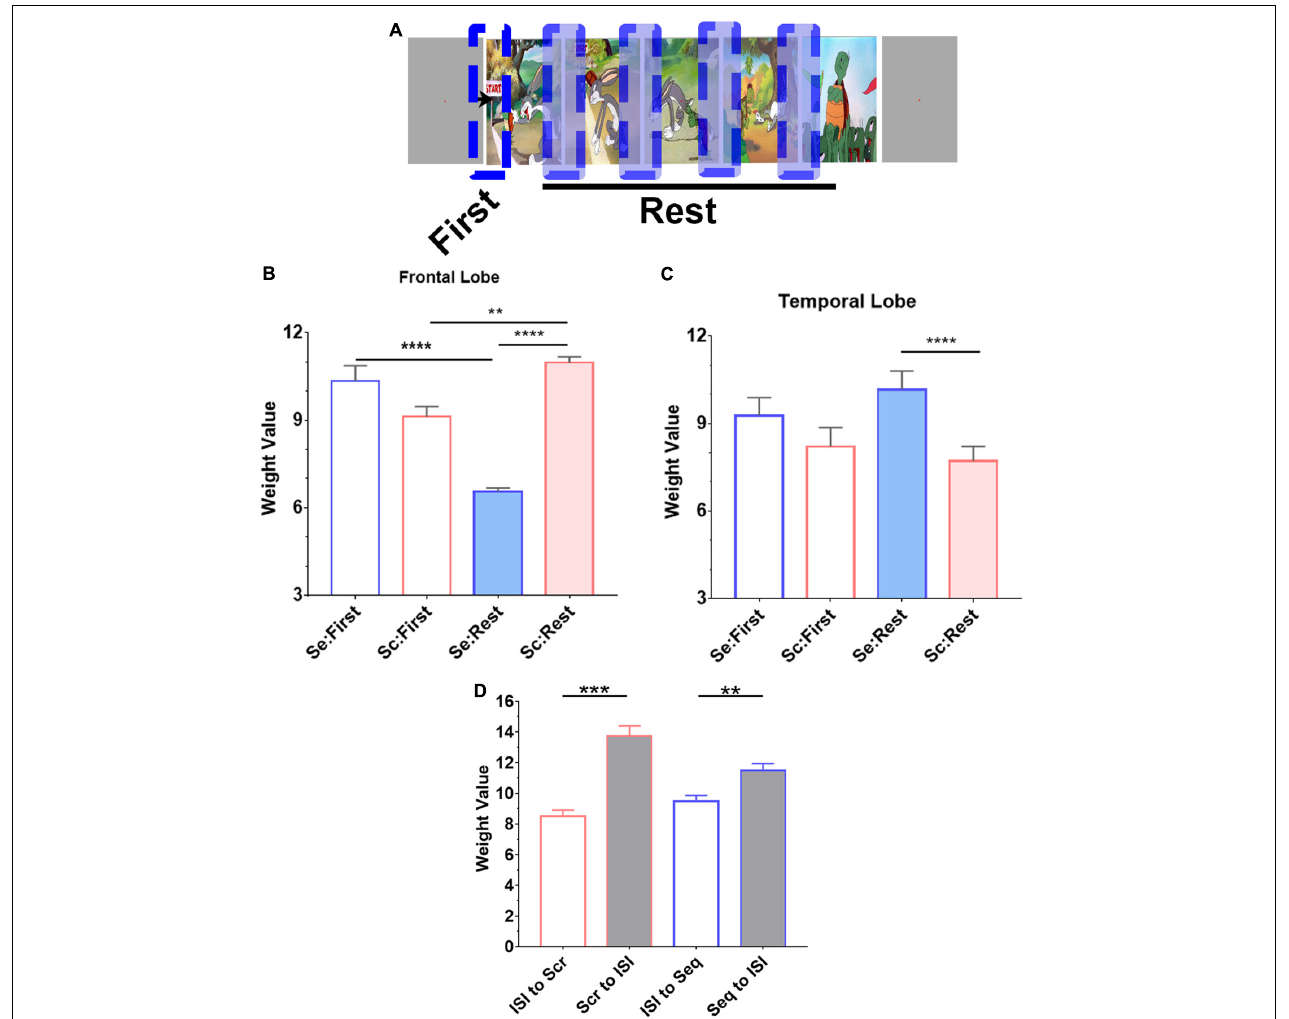
FIGURE 5 | Novelty effect in frontal lobe. (A) Trials from both experimental conditions (Seq and Scr) were grouped into two categories based on the location of the image in the story. “First” denotes the first transition in each image series (or story) whereas “Rest” denotes subsequent transitions. (A, B) In both temporal and frontal lobes, we observe that the first transition response is not different between the two experimental conditions; there was no significant difference in predicted weights between Scr and Seq in the first transition subset ( P > 0.8, Kruskal–Wallis test). However, in the frontal lobe (B) , the subsequent Seq “Rest” group has a significant decrease in the overall weight compared to the first Seq response, Scr Rest group has a significant increase in the overall weight compared to the first Scr response, and Scr Rest group has a significant increase in the overall weight compared to Seq Rest group (** P < 0.01, **** P < 0.0001, Kruskal–Wallis test). (C) In the temporal lobe, the subsequent Seq “Rest” group has an increased overall weights in Seq vs. Scr (**** P < 0.0001, Kruskal–Wallis test). (D) Mean and SEM of the weight values calculated from the transition between ISI to image presentation during Scr and Seq experimental conditions are significantly different from the transition between image to ISI. There is no difference in the weight values calculated from ISI to Scr or Seq transitions. The responses when transitioning to and from ISI in both Scr and Seq experimental conditions are consistent. (one-way ANOVA with Bonferroni’s multiple comparison test. ** P < 0.01 and *** P <